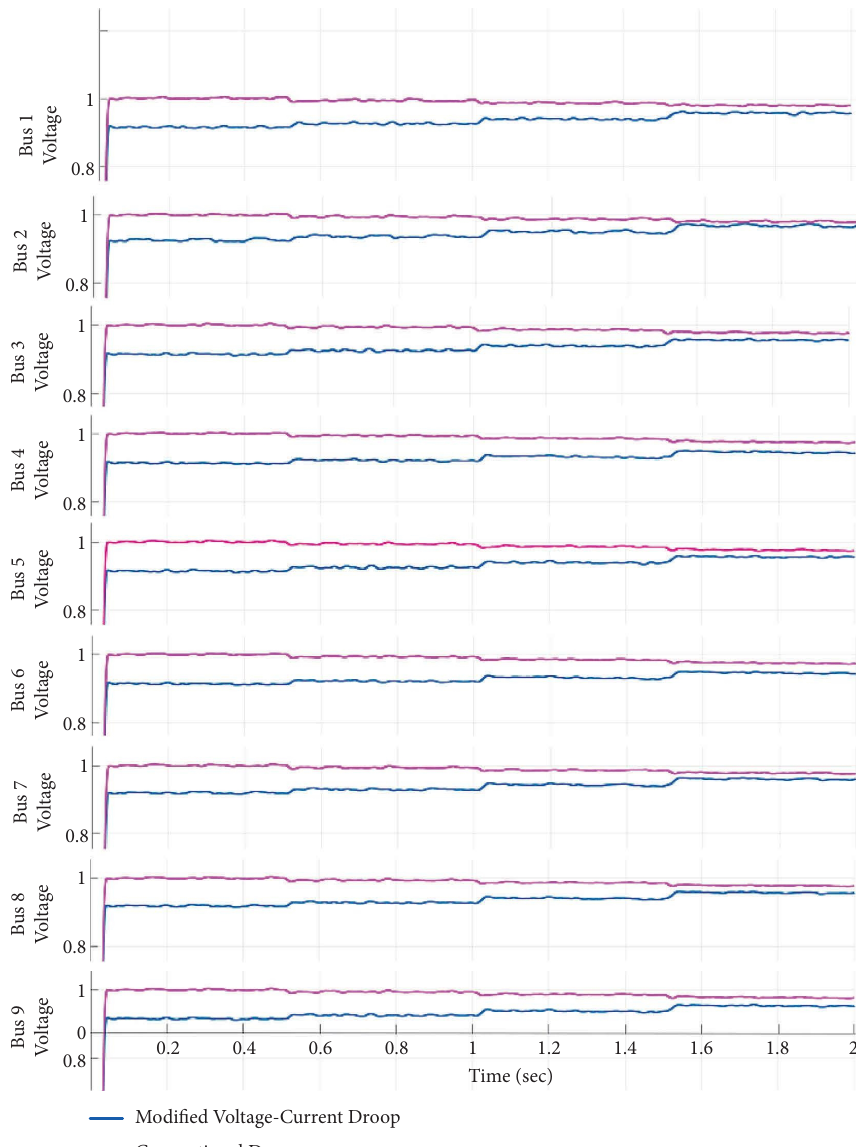
Figure 15: Voltage illustration of IEEE 9 bus microgrid tests